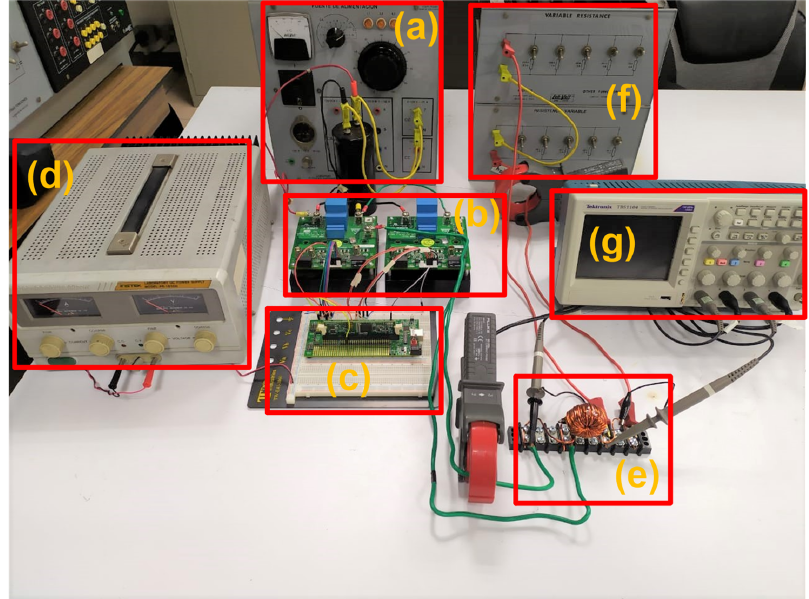
Figure 10. Laboratory prototype with a Full H-Bridge converter, MFT with Nanocrystalline core: ( a ) a DC variable source 0–120 V, ( b ) H Bridge (Mosfets), ( c ) DSP, ( d ) a 12V DC source, ( e ) MFT, ( f ) Load, and ( g ) Oscilloscope.